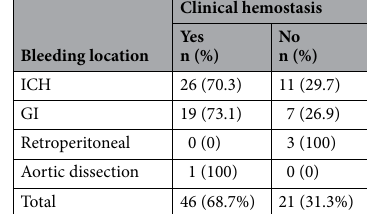
Bleeding location